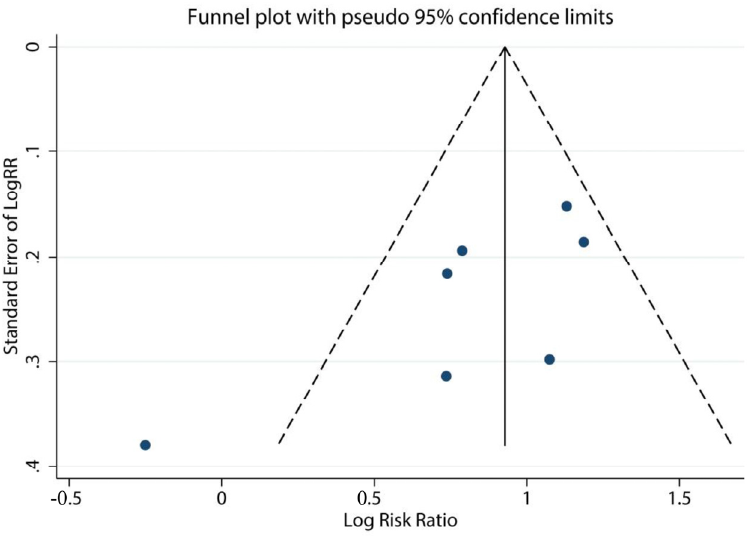
Figure 4. Sensitivity analysis of pleural effusion and the risk of death in PE. PE, pulmonary embolism.